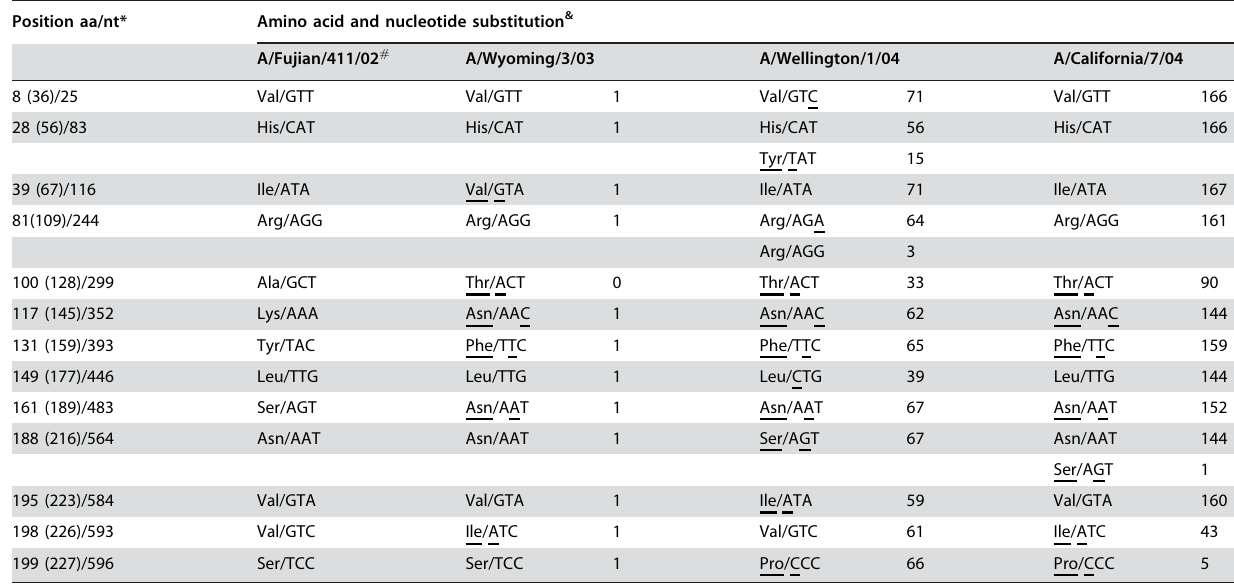
Table 3. Nucleotides difference in hemagglutinin (HA3) genes identified by RPM v.1 from 250 influenza A/H3N2 isolates. .. ... .... ... ... .... ... ... .... ... ... .... ... ... .... ... ... .... ... ... .... ... ... .... ... ... .... ... ... .... ... ... .... ... ... .... ... ... .... ... ... .... ... ... . Position aa/nt* Amino acid and nucleotide substitution &